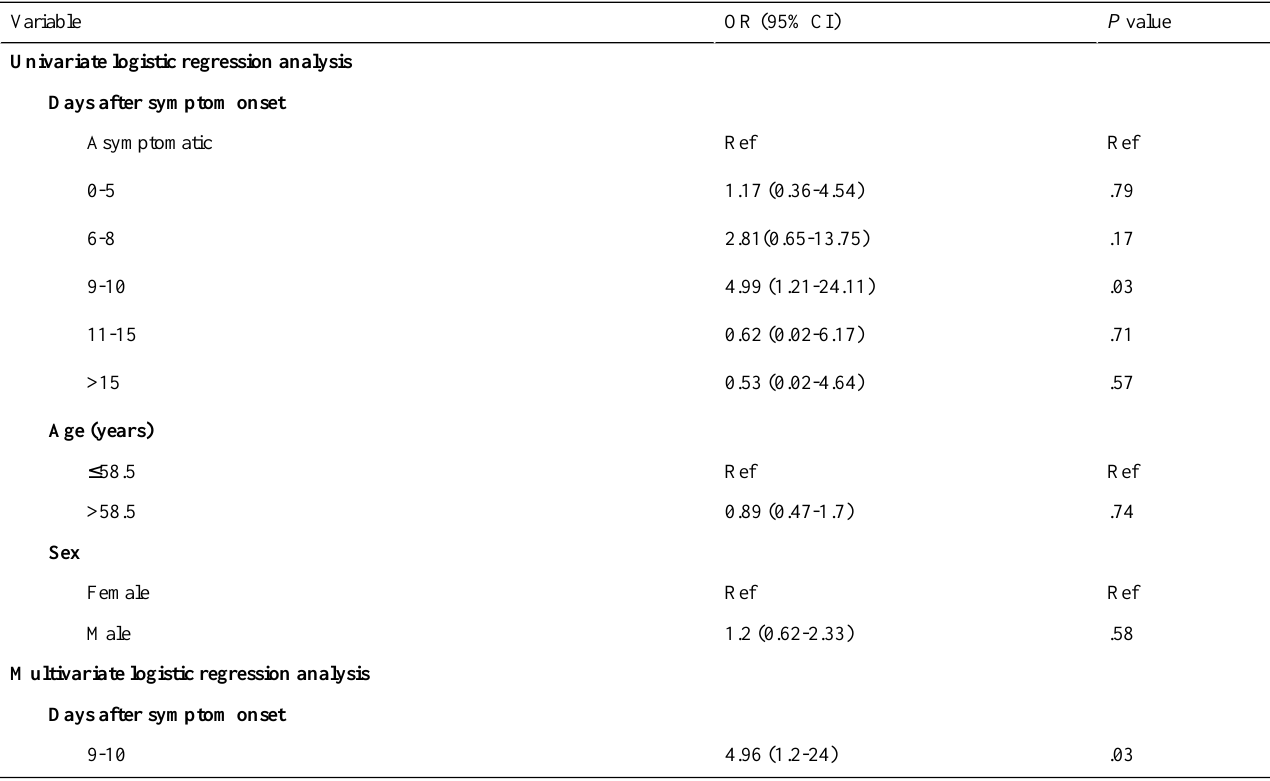
Table 2. Univariate and multivariate logistic regression results using real-time polymerase chain reaction SARS-CoV-2 positivity as a dependent